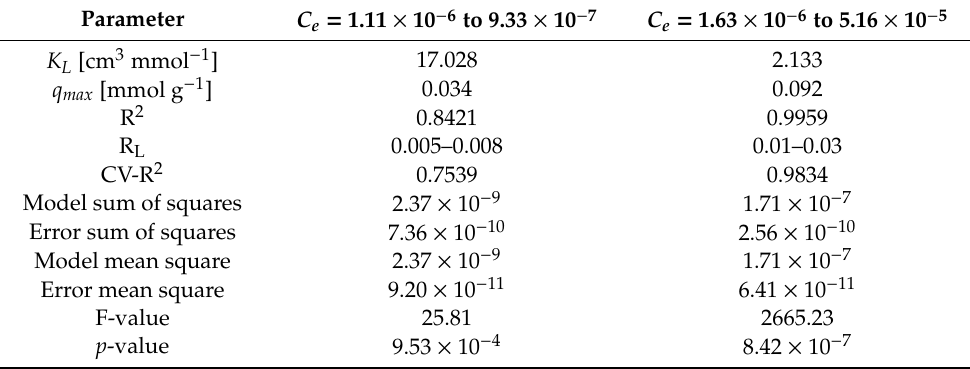
Table 1. Parameters obtained from the linearized form of the absorption isotherms and ANOVA test results.